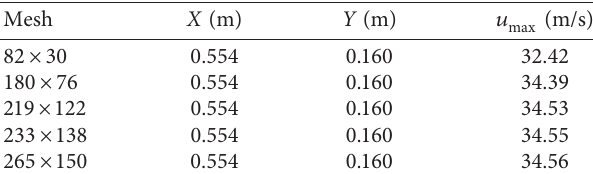
Table 2: Results for grid test on velocity u .